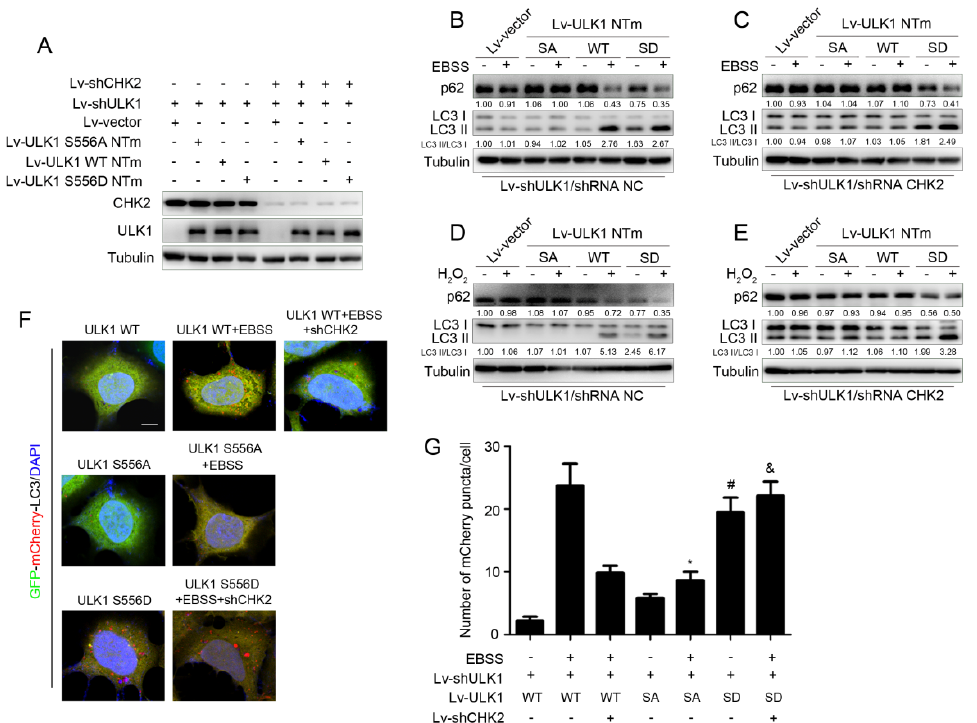
Figure 3. CHK2-mediated ULK1 phosphorylation promotes autophagy. ( A ) Western blot analysis with reconstituted expression of the indicated proteins in H1299 cells. ( B , C ) Western blot analysis of p62and LC3 in H1299 cells with reconstituted expression of ULK1 WT, S556A mutant, or S556D mutant treated with EBSS for 3 h with ( B ) or without ( C ) CHK2. ( D , E ) Western blot analysis of p62 and LC3 in H1299 cells with reconstituted expression of ULK1 WT, S556A mutant, or S556D mutant treated with H 2 O 2 (500 µ M) for 3 h with ( D ) or without ( E ) CHK2. ( F ) The red puncta is shown by representative confocal microscopic images in 293 cells expressing the indicated plasmids treated with EBSS for 2 h. ( G ) Data are presented as mean ± SEM. * ULK1 SA mutant treated with EBSS compared to ULK1 WT treated with EBSS, p < 0.001; # ULK1 SD mutant compared to ULK1 WT, p < 0.001 and & ULK1 SD mutant treated with EBSS without CHK2 compared to ULK1 WT treated with EBSS without CHK2, p < 0.001. Scale bar, 10 μm.